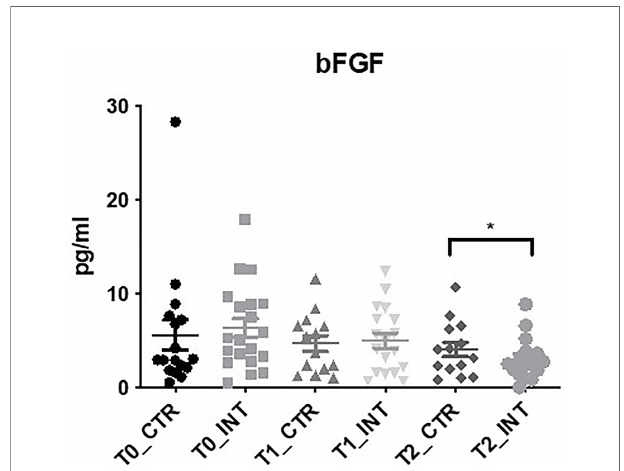
FIGURE 4 | Exercise intervention decreases bFGF expression at T2. Data at immediately post 12-week intervention (Time 1; T1) and at 3-month follow-up (Time 2; T2) was analyzed using linear regression models, adjusting for baseline values (T0). A signi fi cant decrease in serum bFGF expression was observed at T2 between control and intervention cohorts (*p ≤ 0.05).